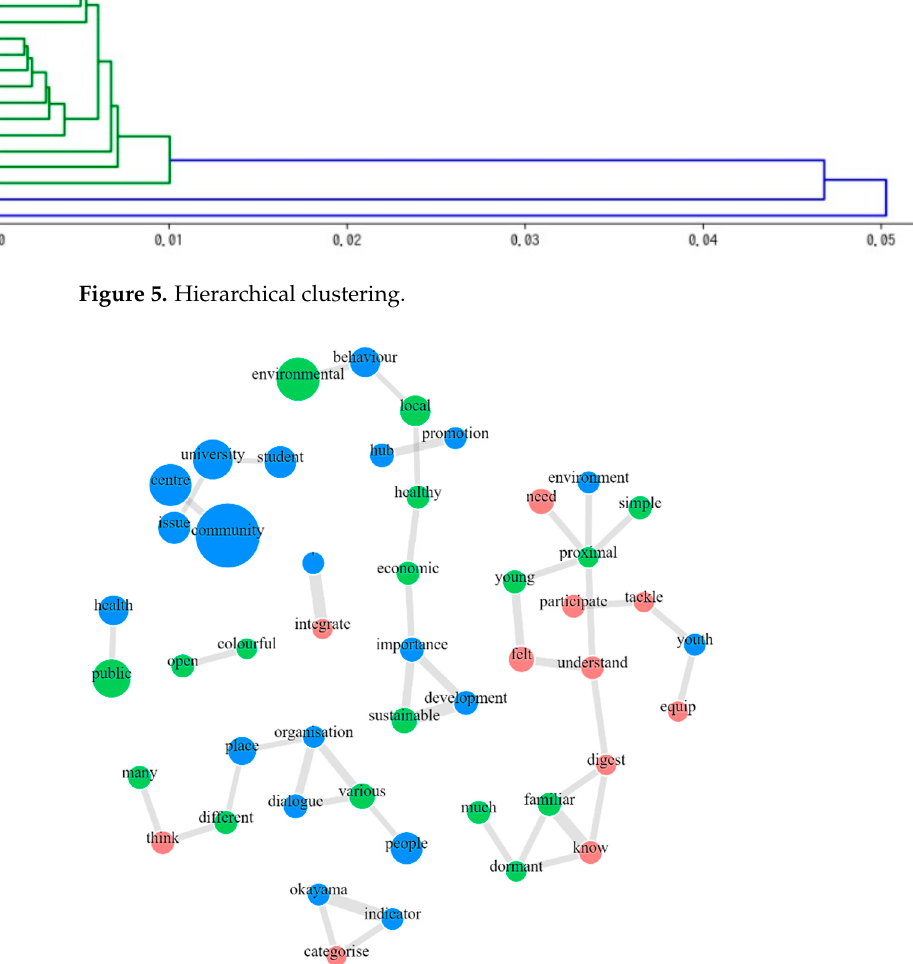
Figure 6. Co-occurrence map.